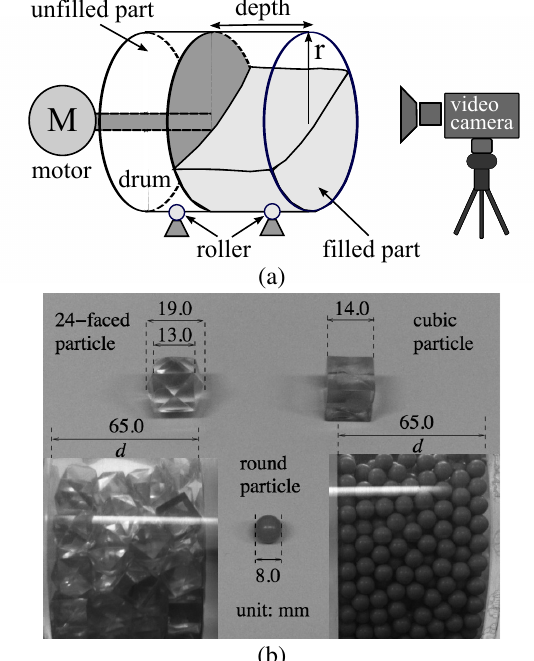
Figure 1. (a) Sketch of the experimental setup; (b) Particles used and snapshots along the depth direction.